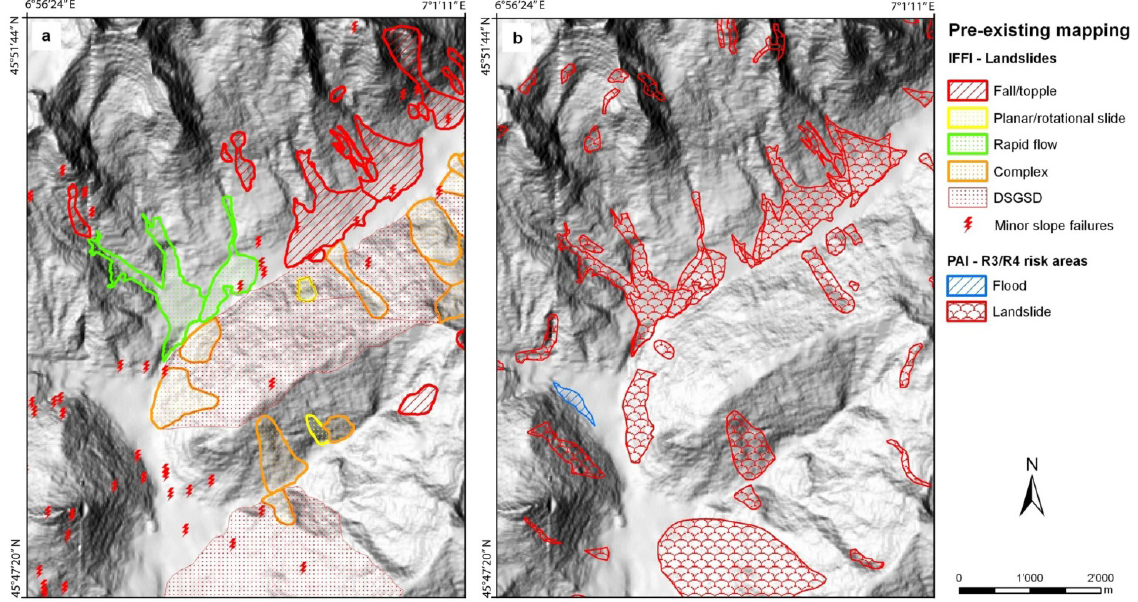
Figure 9. Hillshade of the study area showing ( a ) the IFFI landslide inventory and ( b ) the R3/R4 risk areas as reported in the Hydrogeological Asset Plan PAI .